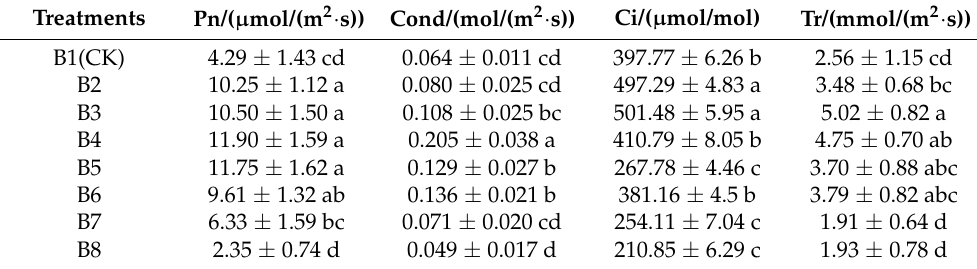
Table 2. Photosynthetic rates of tobacco seedlings under different B application